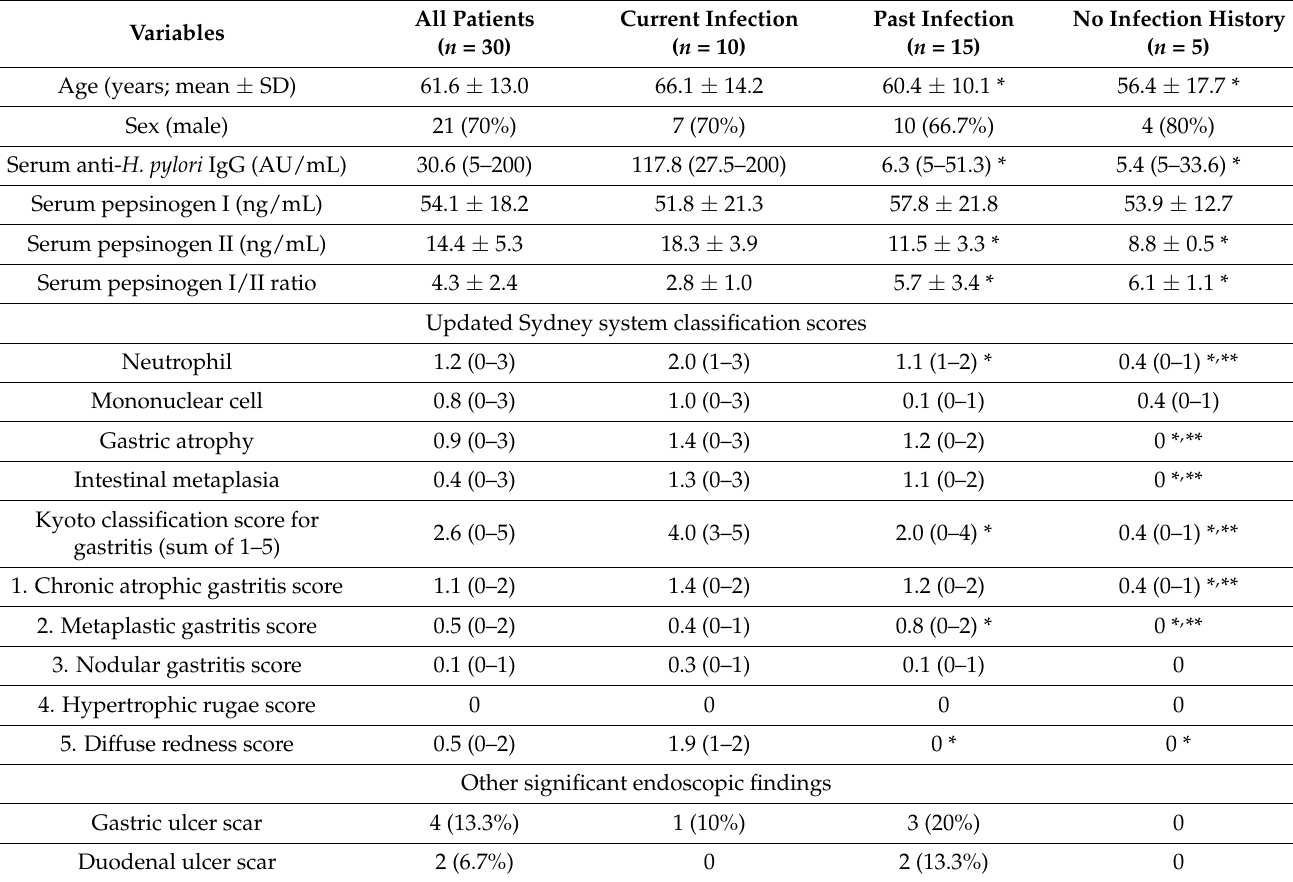
Table 1. Baseline characteristics and test findings of the included